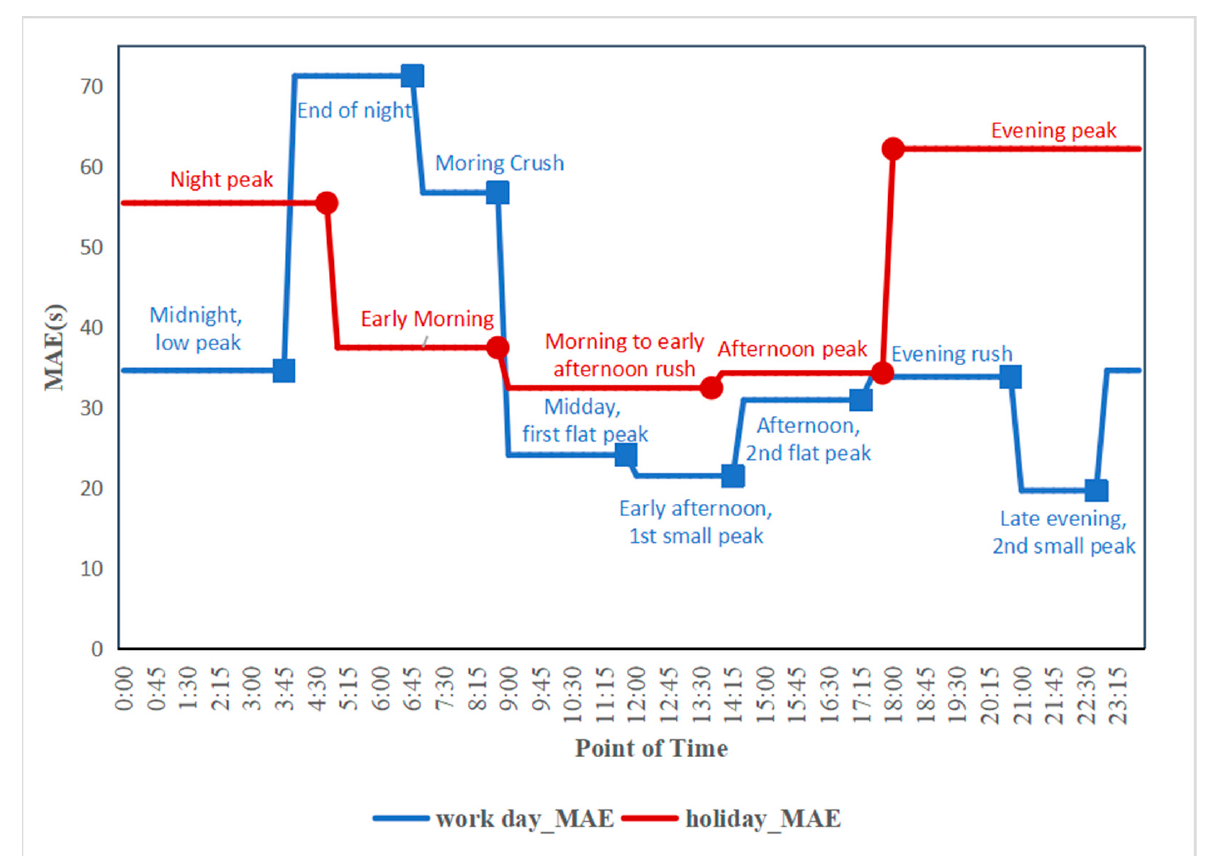
Figure 8. Prediction effect of different time segments.